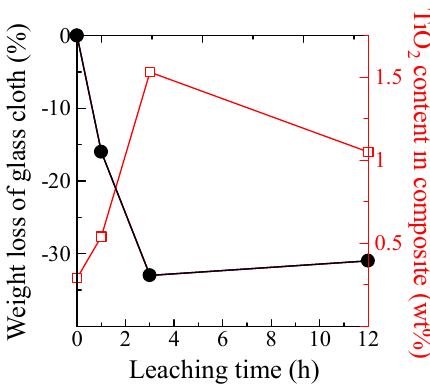
Figure 3. Chemical compositions of the non-porous (0-h leaching time) and porous glass cloths estimated from the X-ray fluorescence (XRF) measurements. The “Others” category includes TiO 2 , Na 2 O, K 2 O, Fe 2 O 3 , and SrO.